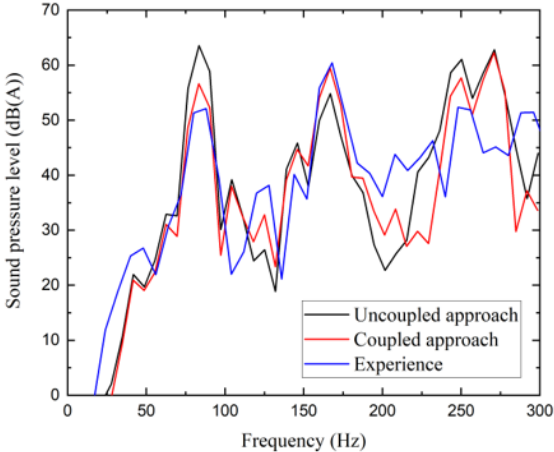
Figure 29. The sound pressure level at the top measuring point in the frequency domain comparison between the two approaches.